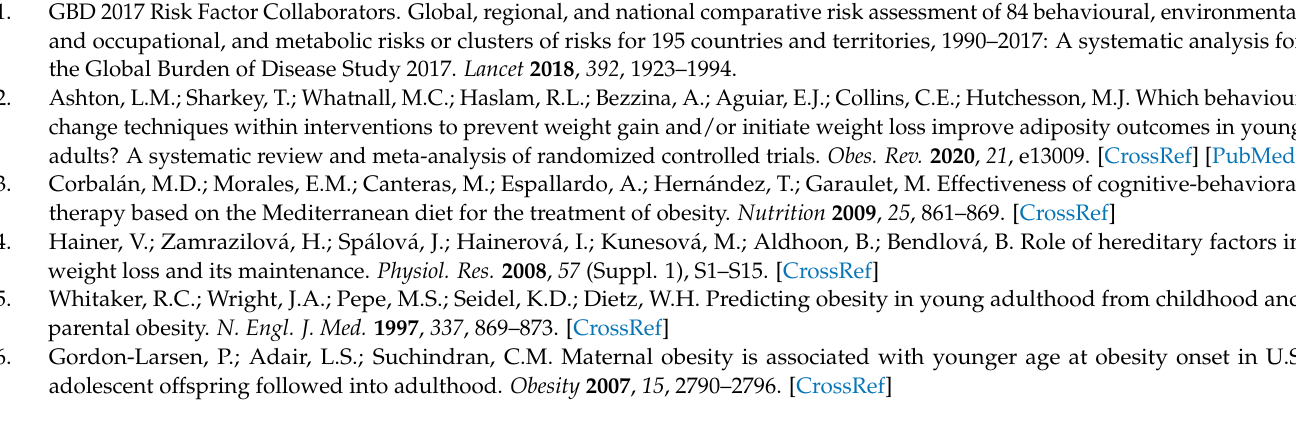
response to the intervention. Table S3. Associations between birthweight, size at birth, and personal life-course obesity grade with total weight loss (kg) in adulthood stratified by sex. Table S4. Adjusted associations between intergenerational obesity grade and total weight loss (kg) in adulthood stratified by adult body mass index (BMI) categories. Table S5. Adjusted associations between intergenerational obesity grade and body mass index (BMI) in adulthood. Table S6. Mutually-adjusted associations between grandparental and parental obesity grade with body mass index (BMI) in adulthood. Table S7. Adjusted associations between intergenerational obesity grade and body mass index (BMI) in adulthood stratified by sex. Figure S1. Associations between birthweight, size at birth, and personal life-course obesity grade with adult body mass index (BMI) in response to the intervention. Figure S2. The relation (and 95% confidence levels) of birth weight with body mass index (BMI) in adulthood. General additive models adjusted for sex and age. Table S8. Associations between birthweight, size at birth, and personal life-course obesity grade with body mass index (BMI) in adulthood stratified by sex. Table S9. Mediation analysis examining the mediated effect of maternal overweight-obesity on BMI in adulthood in the ONTIME study. Table S10. Mediation analysis examining the mediated effect of paternal overweight-obesity on BMI in adulthood in the ONTIME